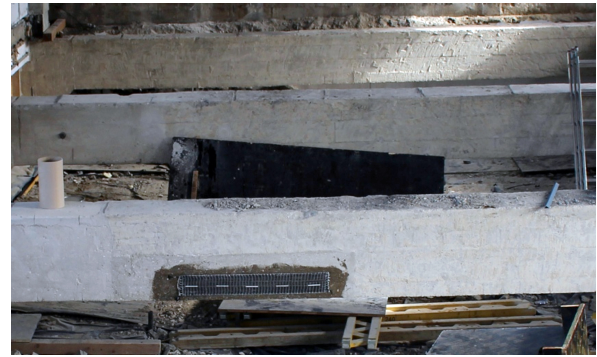
Figure 11: Compressive test on concrete bridge bearing block strengthened with textile sensor.